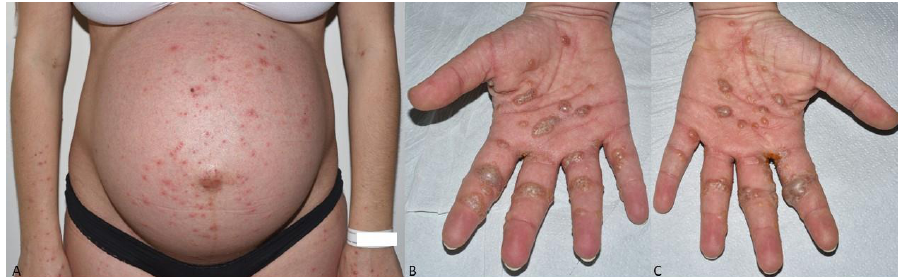
Figure 1. ( A ) Exanthema with erythematous macules and papules on trunk and limbs, with few pustules. ( B ) and ( C ) Tense bullae on